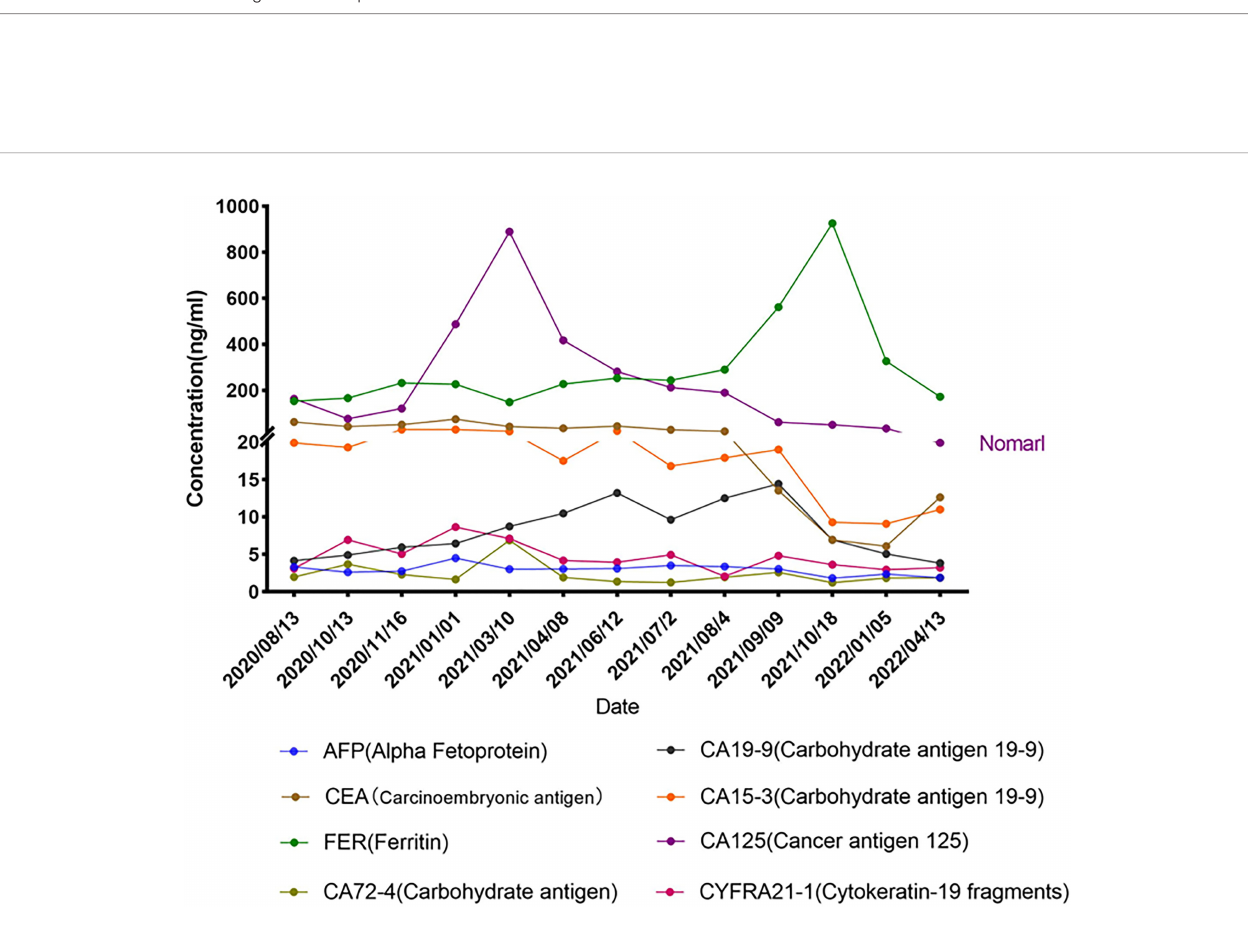
FIGURE 2 | Next-generation sequencing (NGS) panel result showed an epidermal growth factor receptor (EGFR) mutation E746_L747delinsIP via simultaneous deletion and insertion of DNA fragments of 2 bp in exon